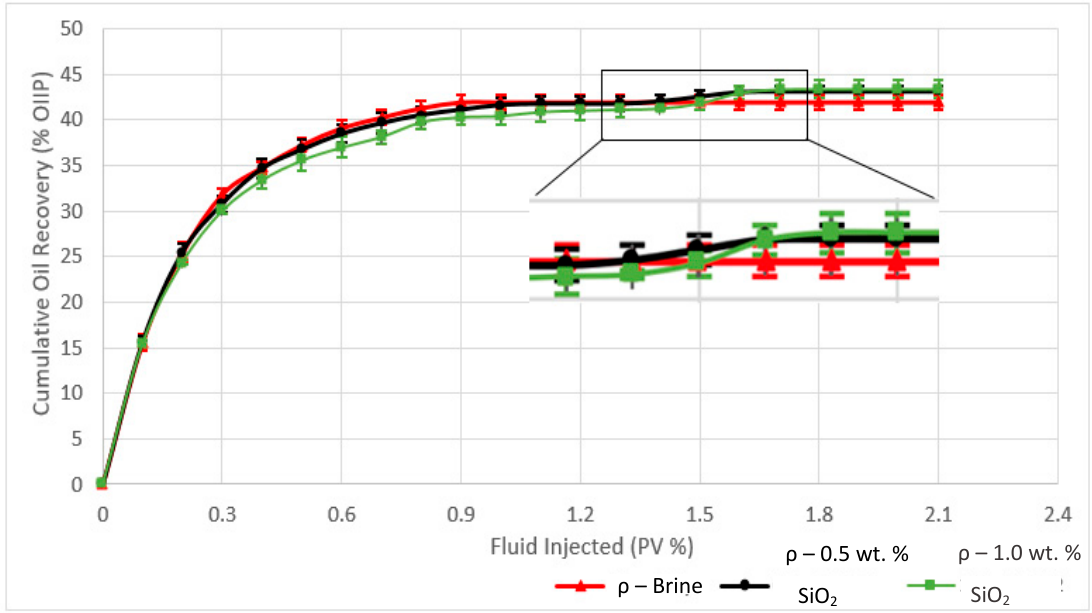
Figure 14. Cumulative oil recovery as a function of injected brine volume (with and without nanoparticles) related to pore volume percentage for the 3 flooding scenarios. The highlighted section reveals the duration of the flood where the nano-EOR effects can be observed.